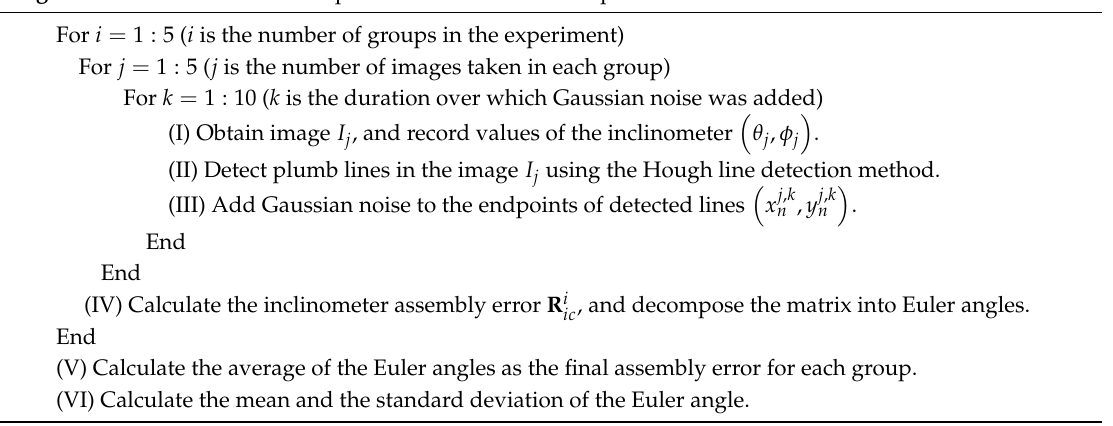
Algorithm 2: Pseudocode of the perturbation simulation